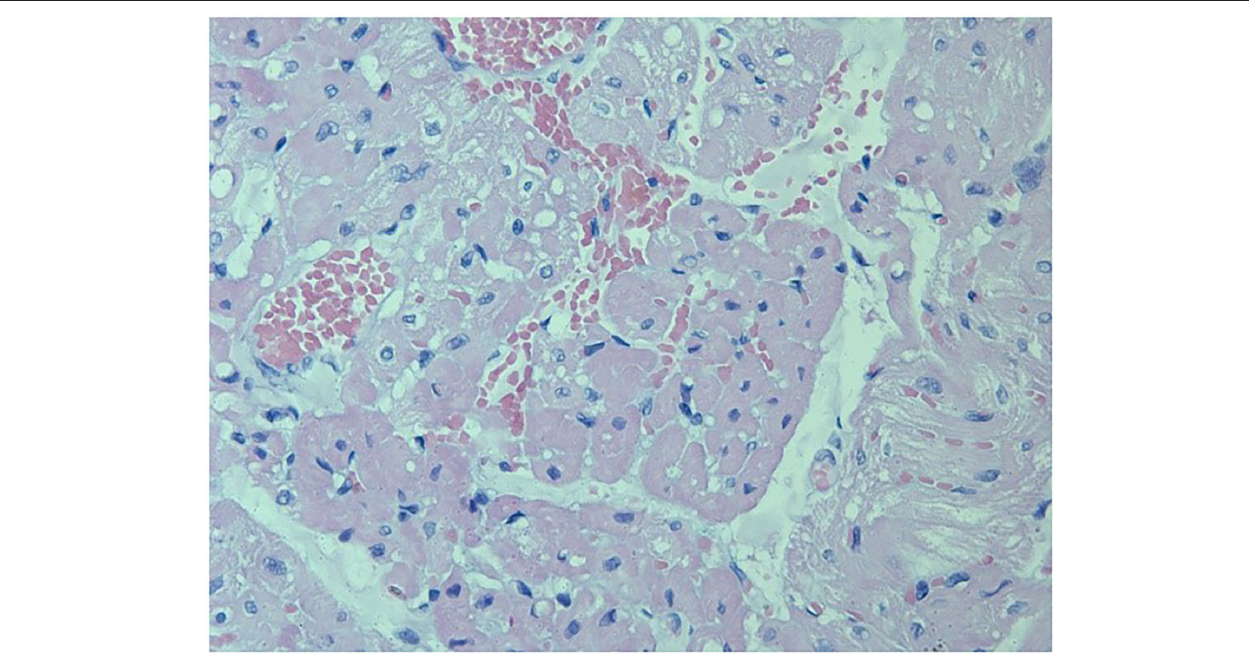
FIGURE 3 | Left ventricle from a rabbit from the VG showing severe and diffuse congestion, with multifocal hemorrhage areas. Multifocal cardiomyocyte degeneration was also observed. Besides undergoing immunization protocols, this rabbit also underwent the trial period receiving a 7 µ g of L. intermedia venom (HE, 400X). Periodic acid Schiff (P.A.S.) stain was not